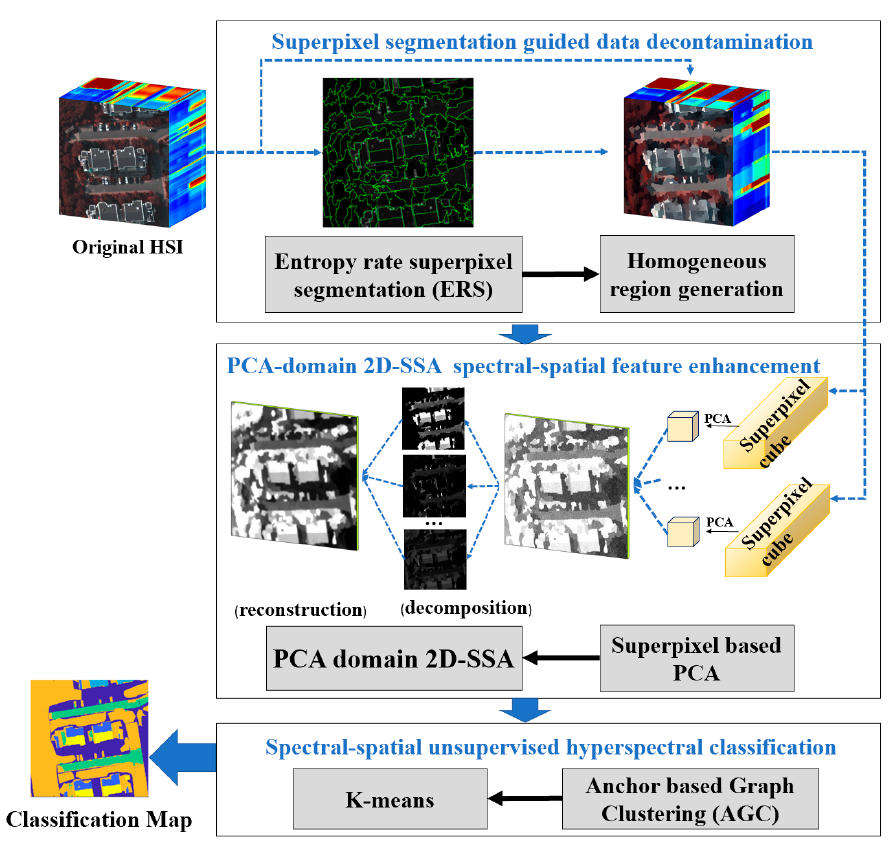
Figure 1. Outline of the PSSA framework for superpixelwise unsupervised HSI classification.